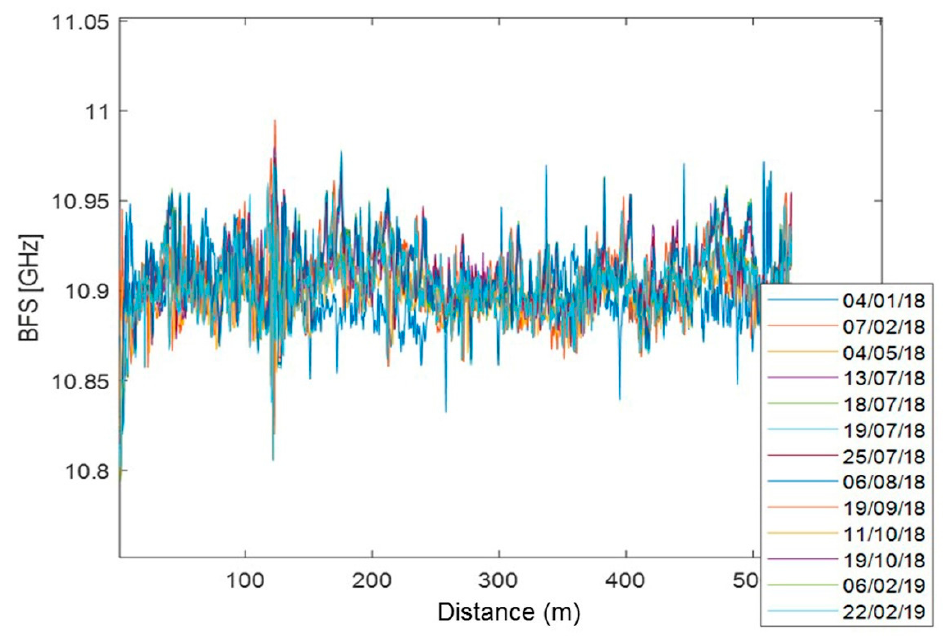
Figure 20. BFS profiles acquired from January 2018 to February 2019.